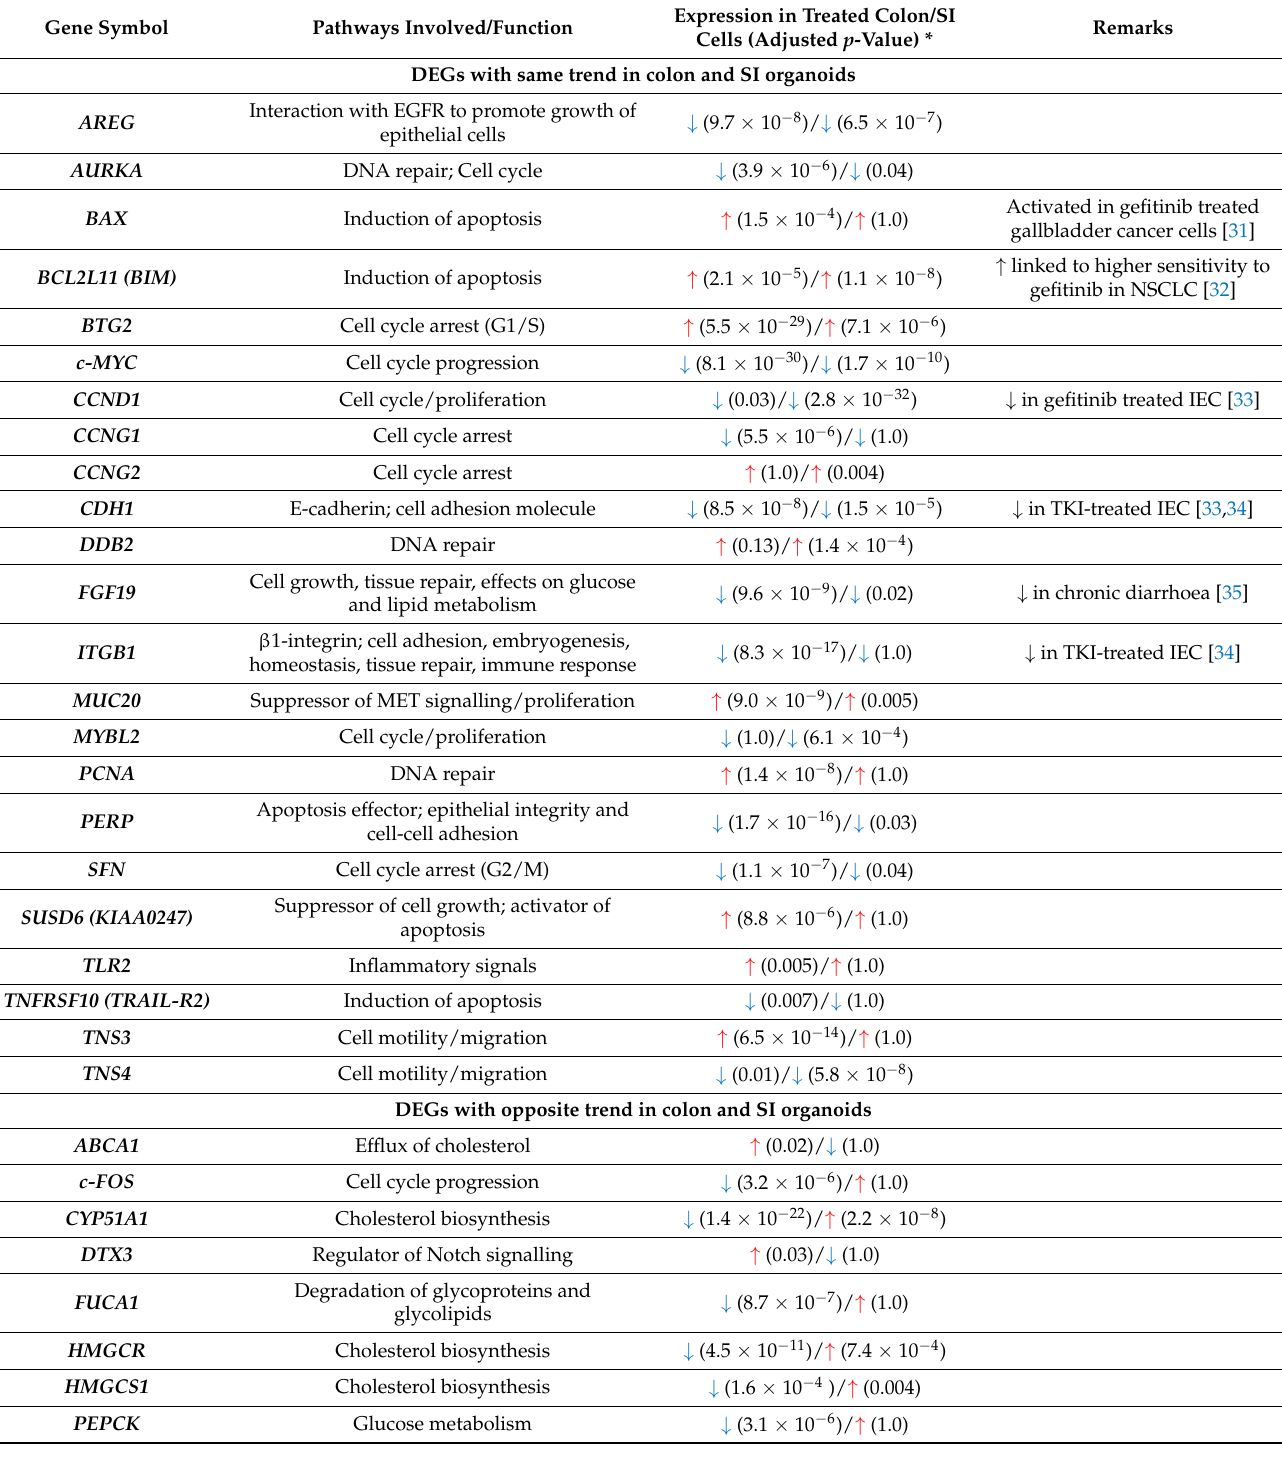
Table 3. Expression changes of the DEGs affected by gefitinib in colon and SI